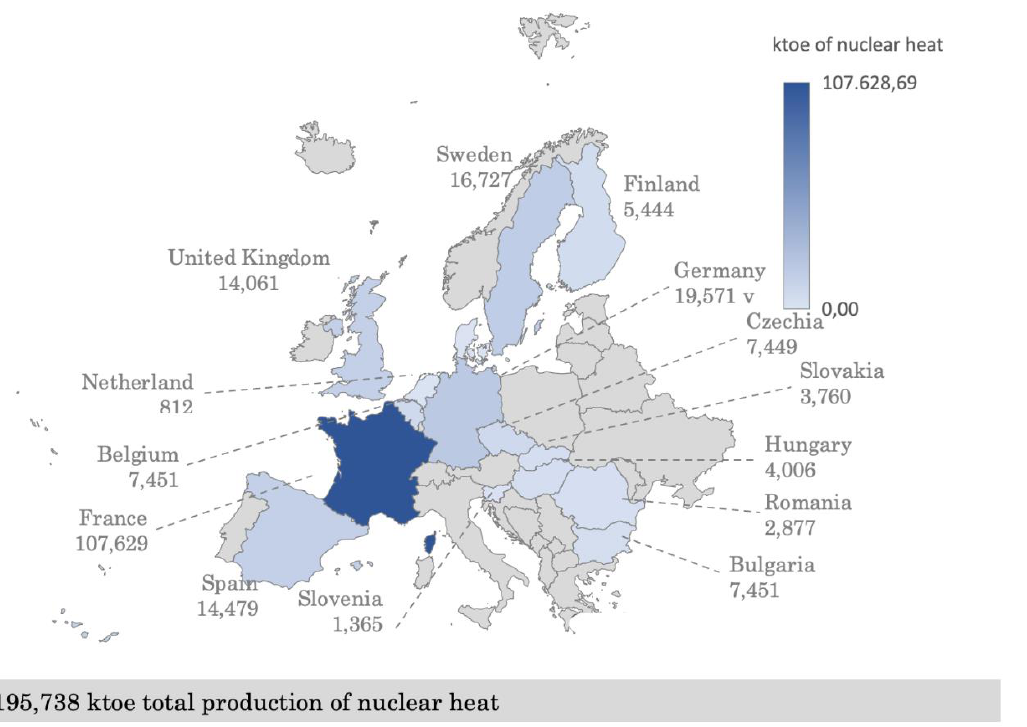
reactors. According to the “programmation pluriannuelle de l’ é nergie” (PPE), the “weight” of nuclear power will have to drop to 50% of the electrical mix in